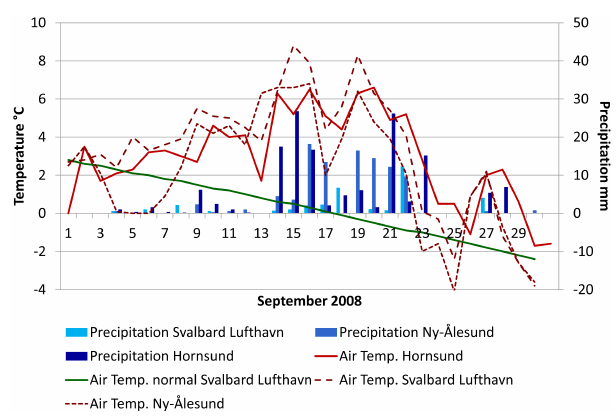
Fig. 8. Daily temperature and precipitation in Ny-Ålesund, Longyearbyen (Svalbard Lufthavn) and Hornsund (location in Fig. 1) in September 2008, immediately prior to surge advance. Data are from the Norwegian Meteorological